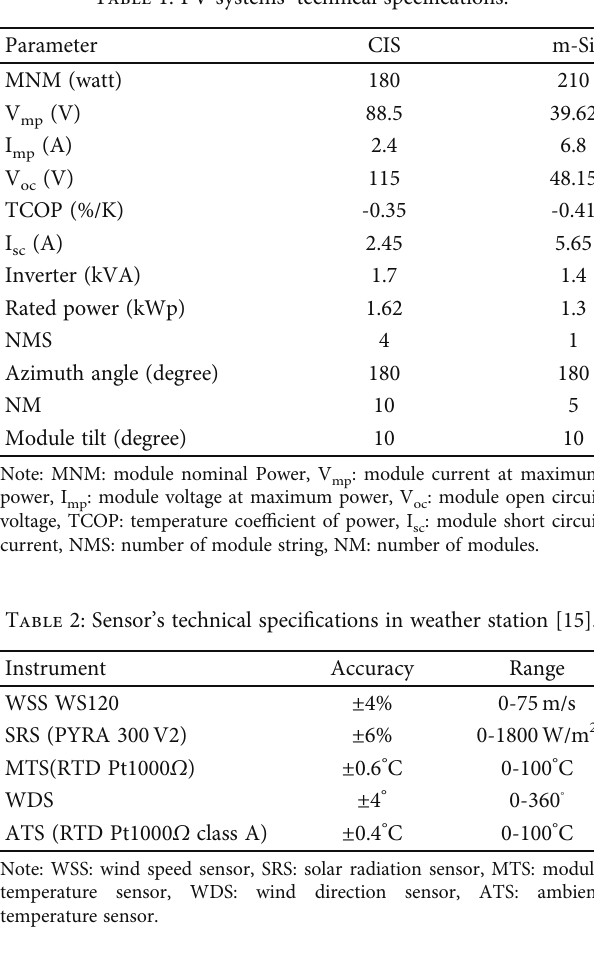
Table 1: PV systems ’ technical speci fi cations.